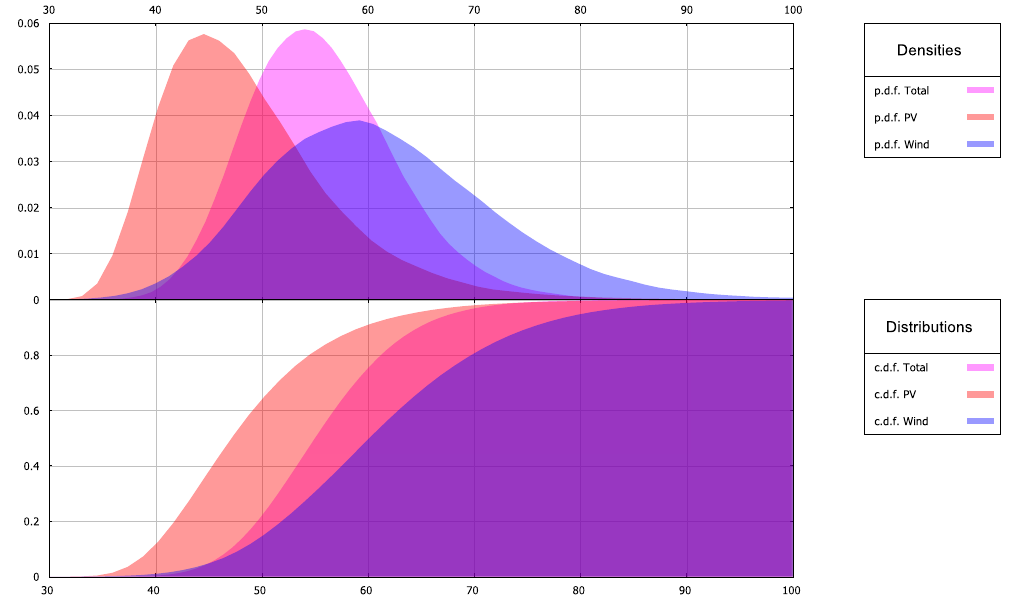
Figure 4. IEA Roadmap LCOE (USD / MWh): PV, wind and overall values.